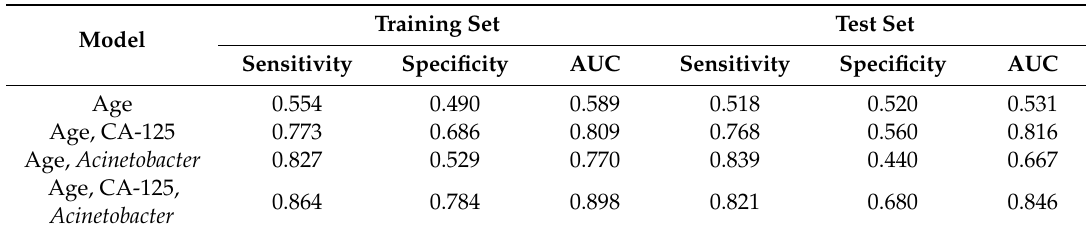
Table 3. Diagnostic models differentiating ovarian cancer from benign ovarian tumors.